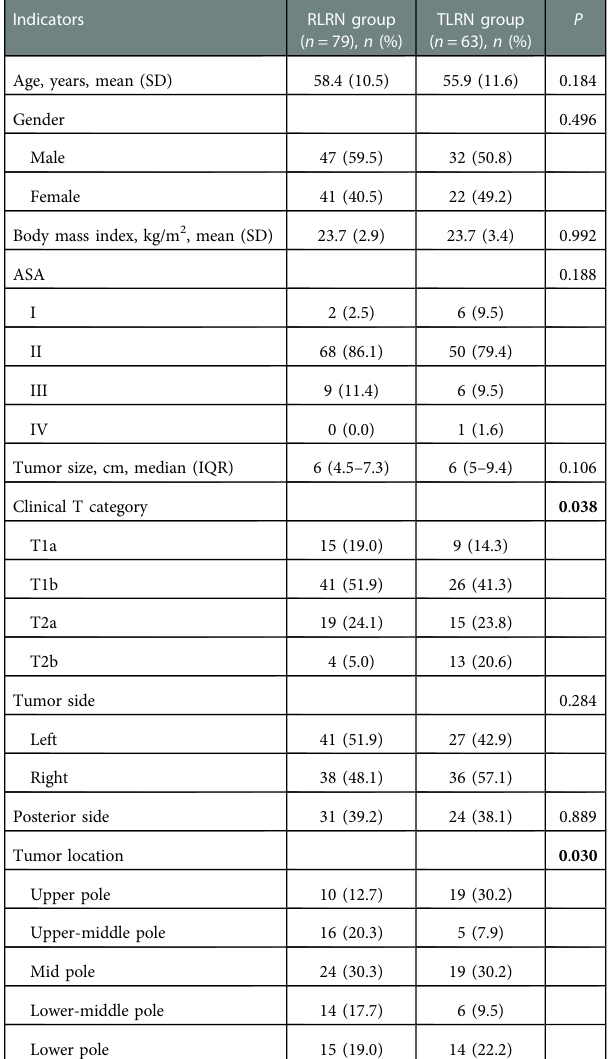
TABLE 1 Demographic data and characteristics of patients who received RLRN or TLRN. Indicators